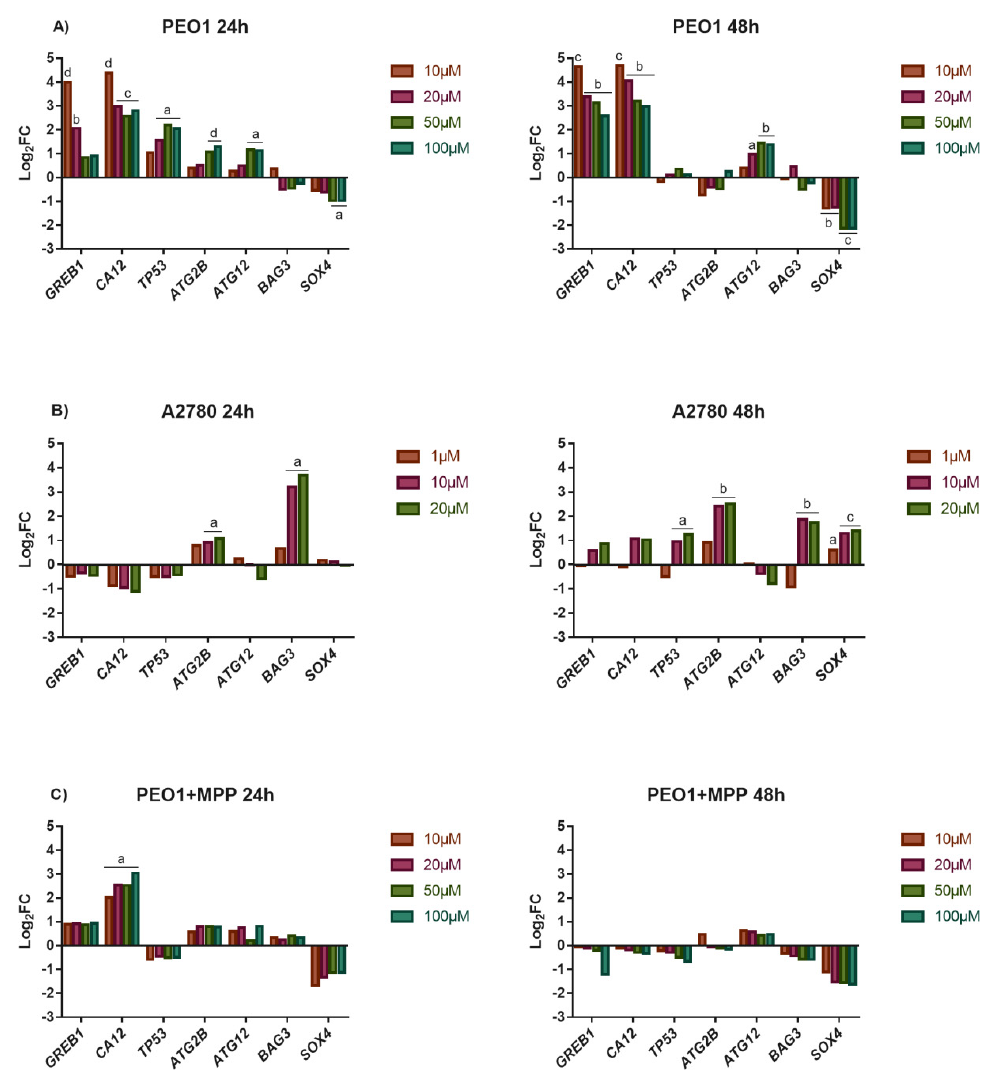
Figure 3. Study the effect of high-dose E2 exposure on gene expression. Log 2 FC values of the selected genes were determined in response to E2 treatment in the PEO1 ( A ) and A2780 ( B ) cell lines as well as in the PEO1 cell line in the presence of 10 nM MPP ( C ). The total RNA was isolated from the cells at 24 h and 48 h after E2 treatment. Significance was determined between the ∆ CT values of the treated and non-treated samples. a: p < 0.05; b: p < 0.01; c: p < 0.001; d: p < 0.0001.